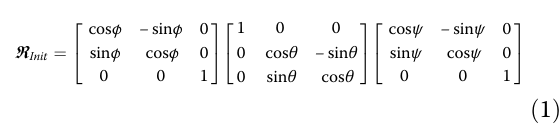
ð 1 Þ where t m is the slow time, T p is the pulse signal repeti- tion period, and K r is the frequency modulation slope. Δ R target to a radar at time t m , and R ref ( t m ) is the distance from the target center to the radar at time t m .